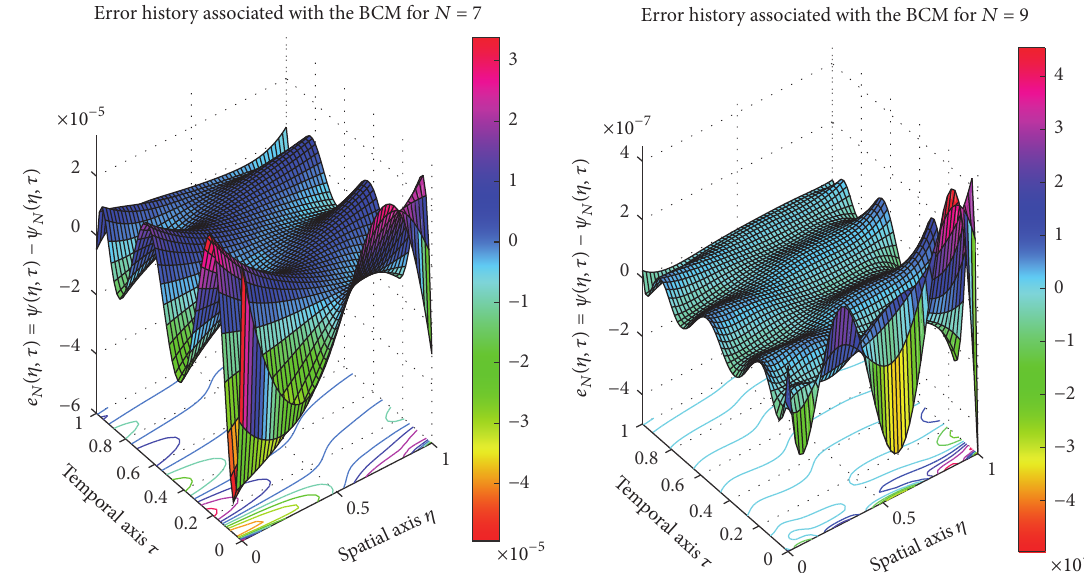
Figure 5: Error histories associated with the obtained numerical solution of the first example for 𝑁 = 7, 9 .